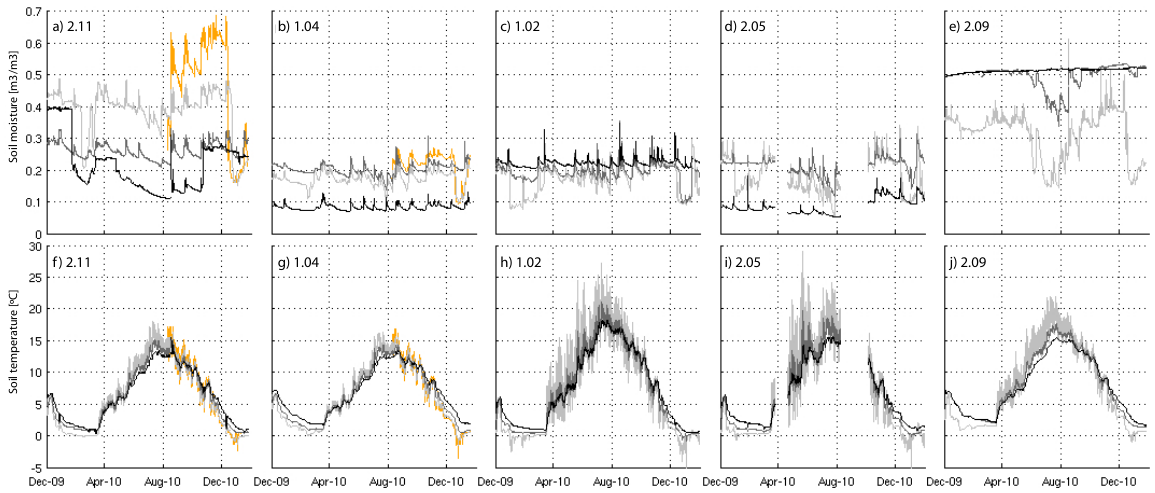
Fig. 8. Profiles of soil moisture (a–e) and temperature (f–j) for the year 2010: for stations (a/f) 2.11 (heath, class 612/HSS), (b/g) 1.04 (forest, class 512/FSS), (c/h) 1.02 (agriculture, class 212/ASS, HOBE site Voulund), (d/i) 2.05 (agriculture, class 212/ASS), and (e/j)